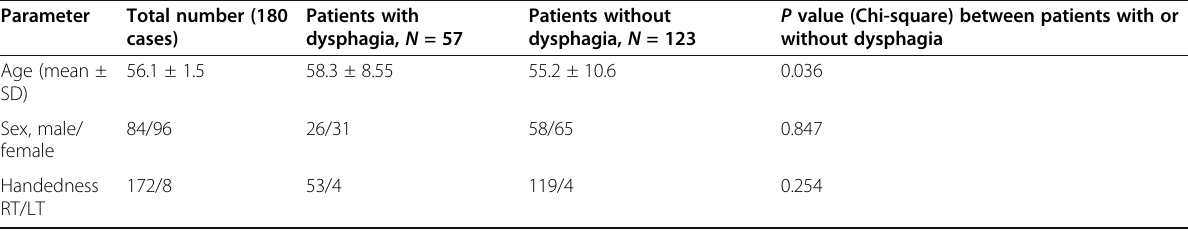
Table 1 Demographic data of all ischemic stroke patients